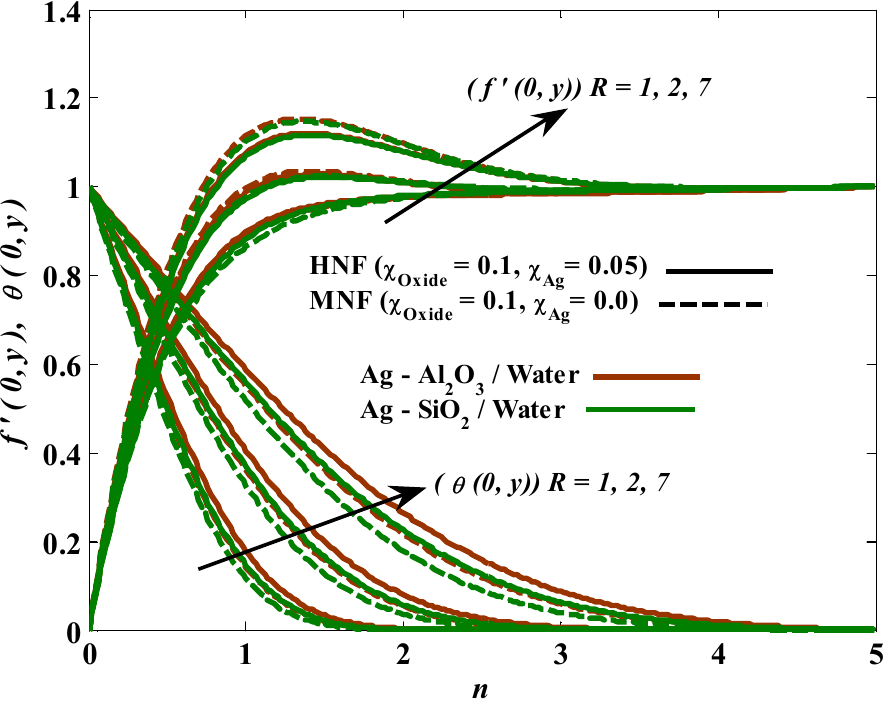
Figure 12. Illustration of R versus temperature and velocity at fixed values of We = 0.2, λ = 0.1, & M = 1.